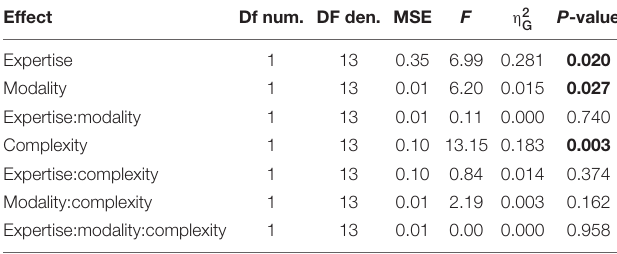
TABLE 3 | Repeated measure ANOVA—synchronization precision (experiment 2).